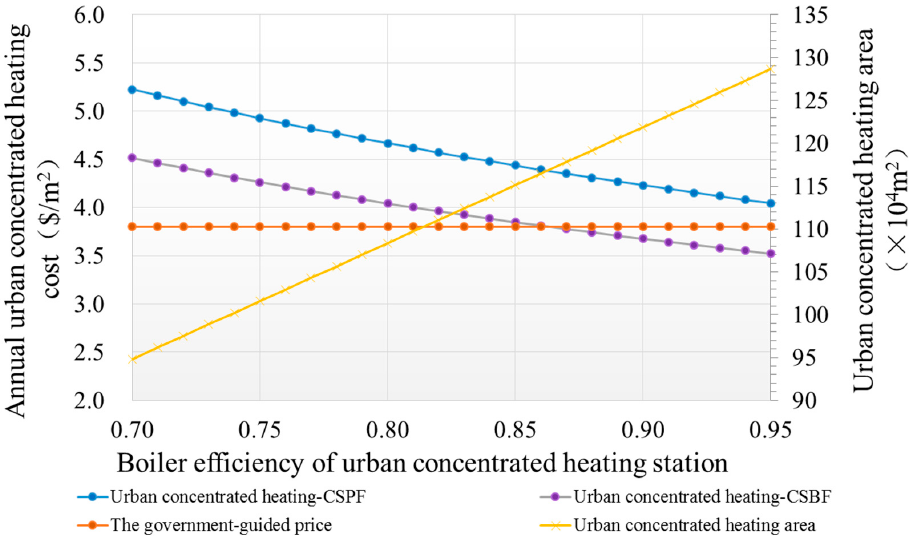
Figure 14. Influence of boiler energy efficiency on the economic performance of a CSDF-DHS.